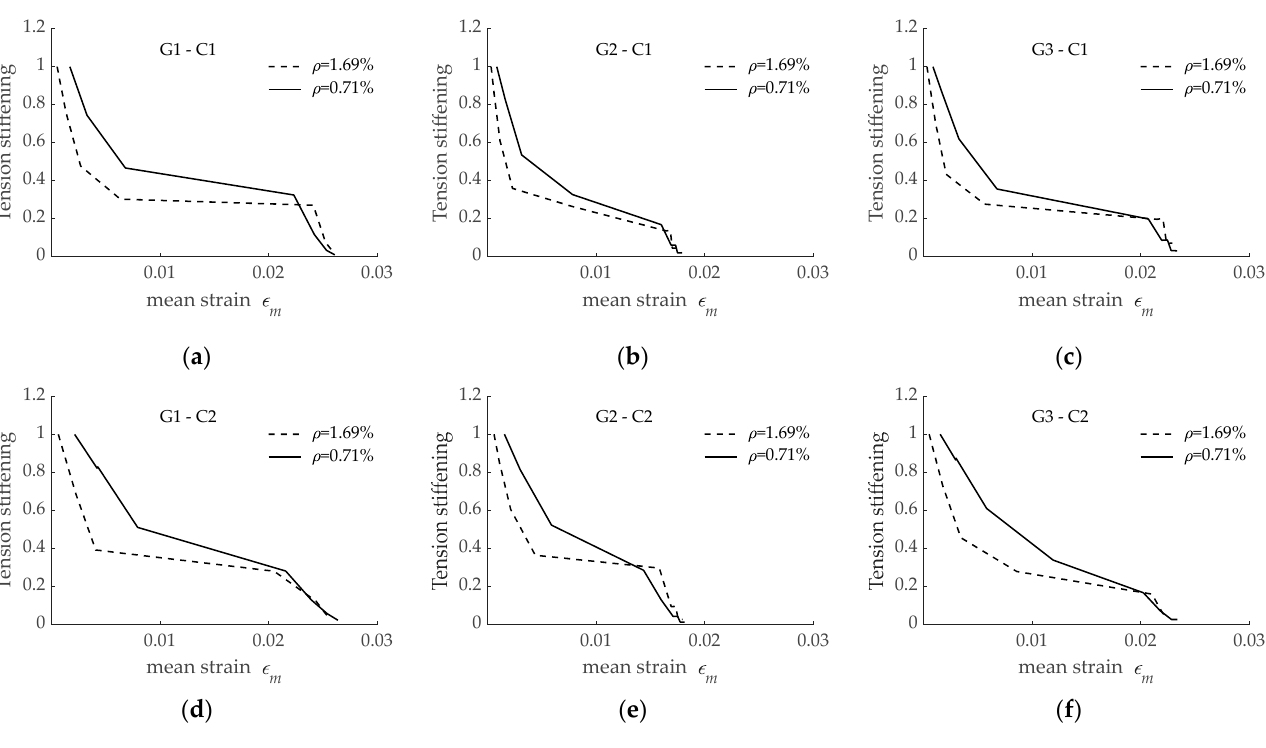
Figure 16. Effect of reinforcement ratio on tension stiffening predicted for: ( a ) bar G1 embedded in C1; ( b ) bar G2 embedded in C1; ( c ) bar G3 embedded in C1; ( d ) bar G1 embedded in C2; ( e ) bar G2 embedded in C2; ( f ) bar G3 embedded in C2.